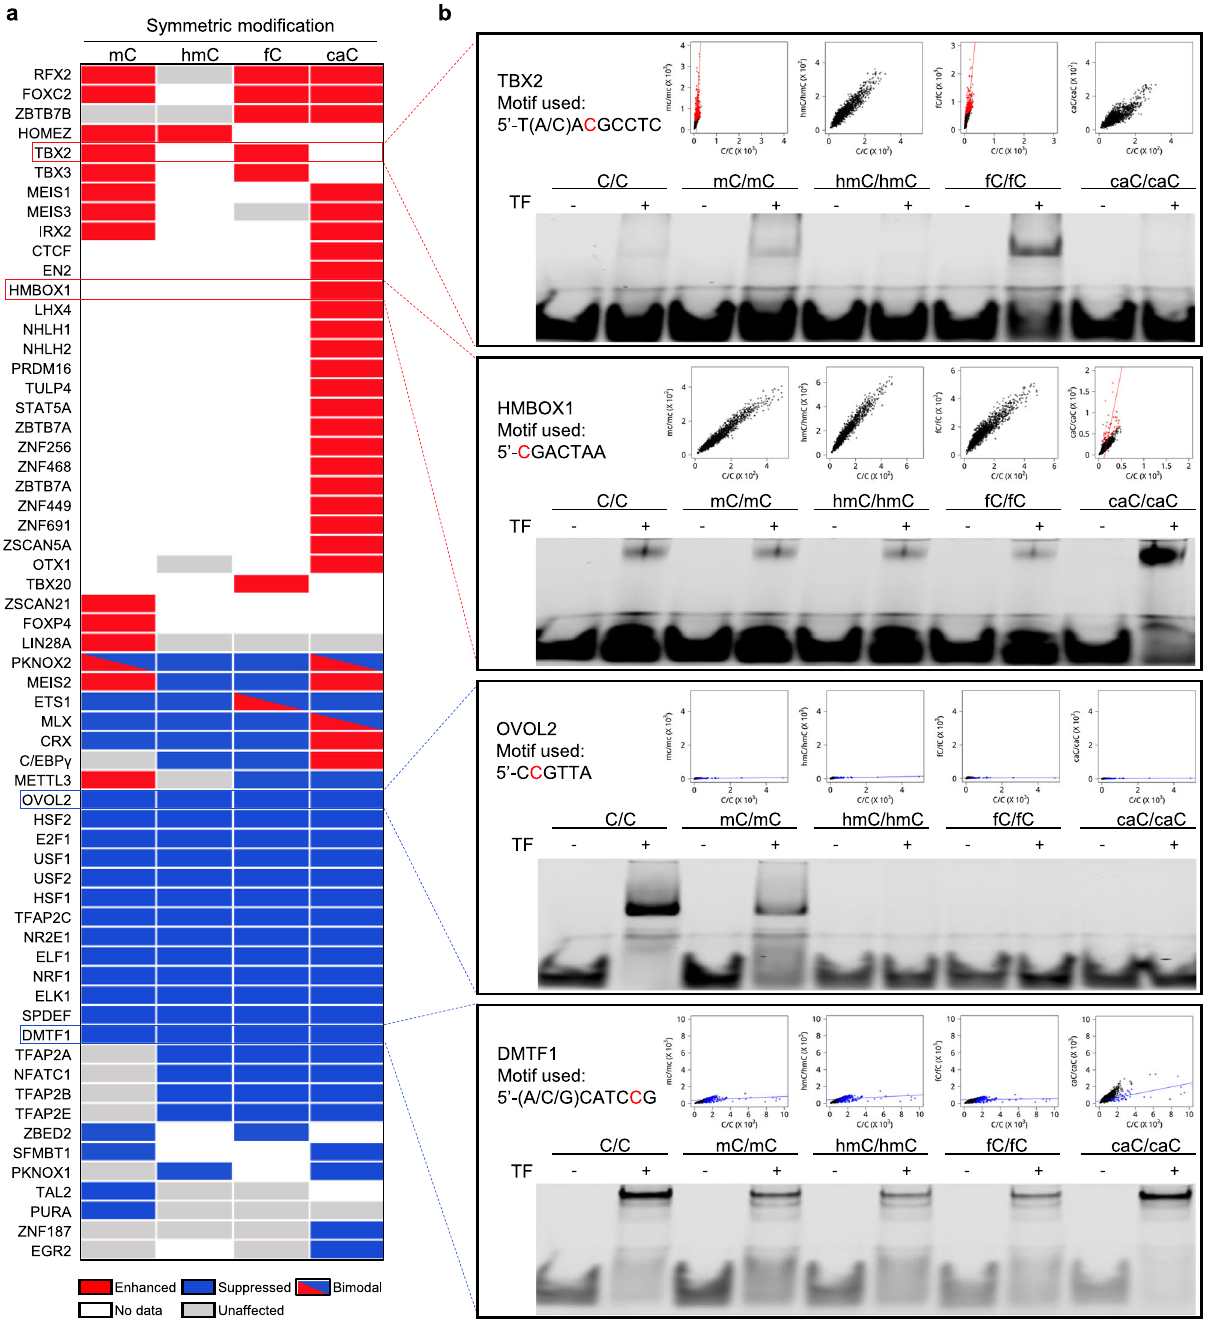
Fig. 4 Three scenarios of symmetric modi fi cation impact on TF-DNA interactions. a A given TF-DNA interaction can be enhanced (red bricks), suppressed (blue bricks), or unaffected (gray bricks) by any of the four symmetric epigenetic modi fi cations. Note that some modi fi cations could enhance and suppress TF-DNA interactions depending on the sequence context (bimodal). The same scenarios were also observed for hemi-modi fi cations (Supplementary Data 7, 8, and Supplementary Fig. 7). b Validation of modi fi cation-enhanced (i.e., TBX2 and HMBOX1) or suppressed (i.e., OVOVL2 and DMTF) TF-DNA interactions using electrophoretic mobility shift assays (EMSA). The sequences of the DNA probes used in the EMSA are shown in each box with the modi fi ed C labeled in red. The protein concentrations of TBX2, HMBOX1, OVOL2, and DMTF1 were 26.2, 355.6, 563.3, and 156 nM,